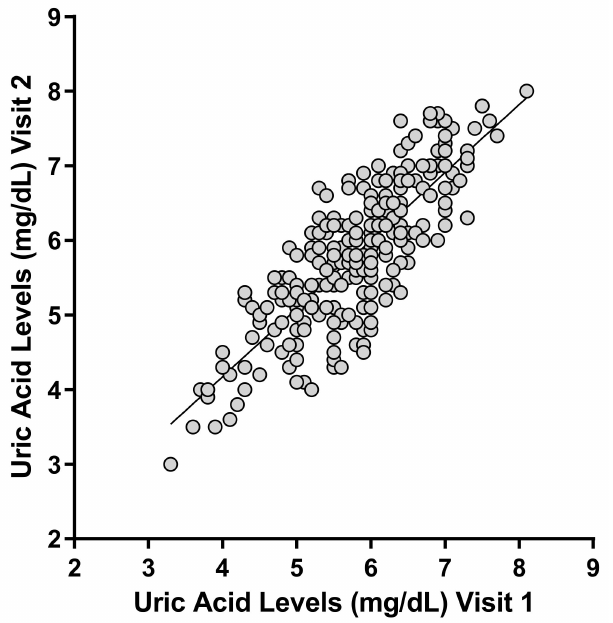
Figure 1. Observed uric acid levels in 250 healthy male subjects. The intraclass correlation coefficient between uric acid measured at visits 1 and 2 was 0.8075. Table 1. Demographics of the